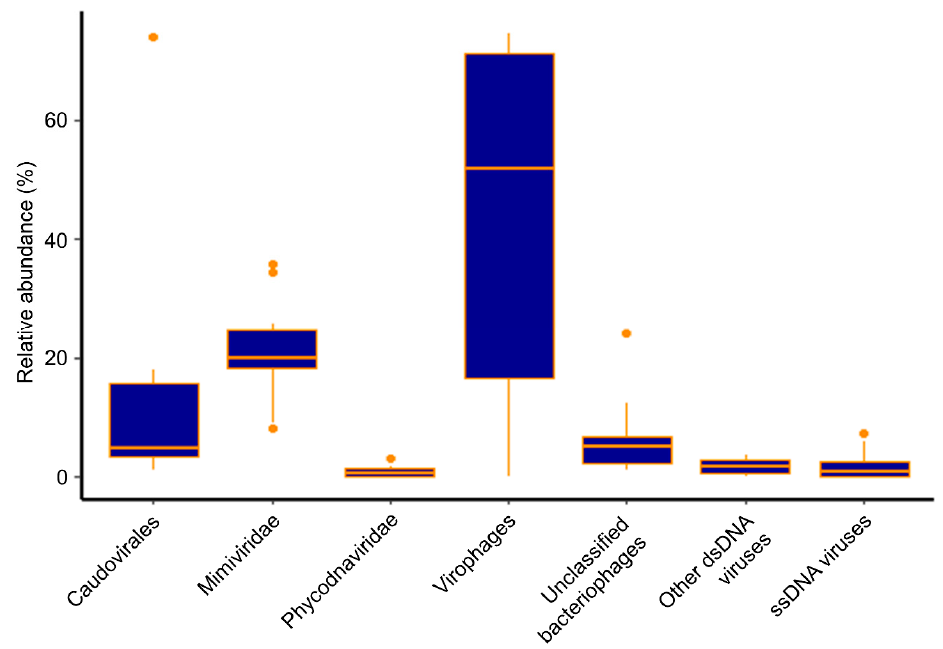
Figure 1. Boxplot of the overall virus community in Hamilton Harbour based on all 10 metagenomes from the 5 sampling dates at the nearshore and mid-harbour sites.